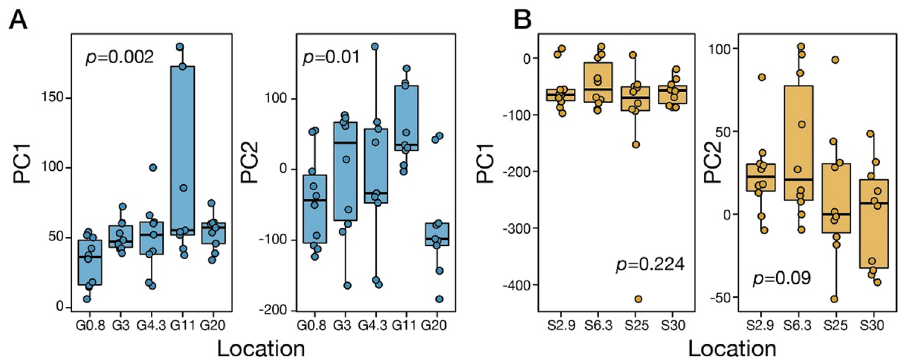
Figure 4. Principal component analysis using expression profiles of both rivers. Boxplots show the variance of PC1 and PC2 values of each population in the gentle ( A ) and steep rivers ( B ). In each panel, p -values based on analysis of variance are